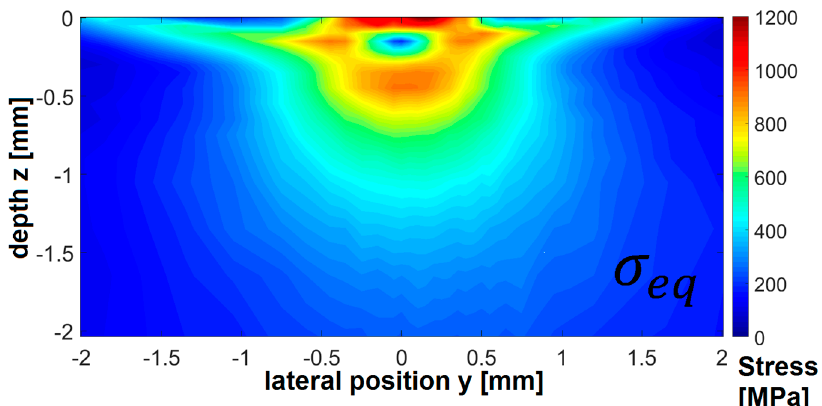
Figure 2. Internal full stress fields below the contact point at 3000 N external force in equivalent σ eq ( y , z ) stress.